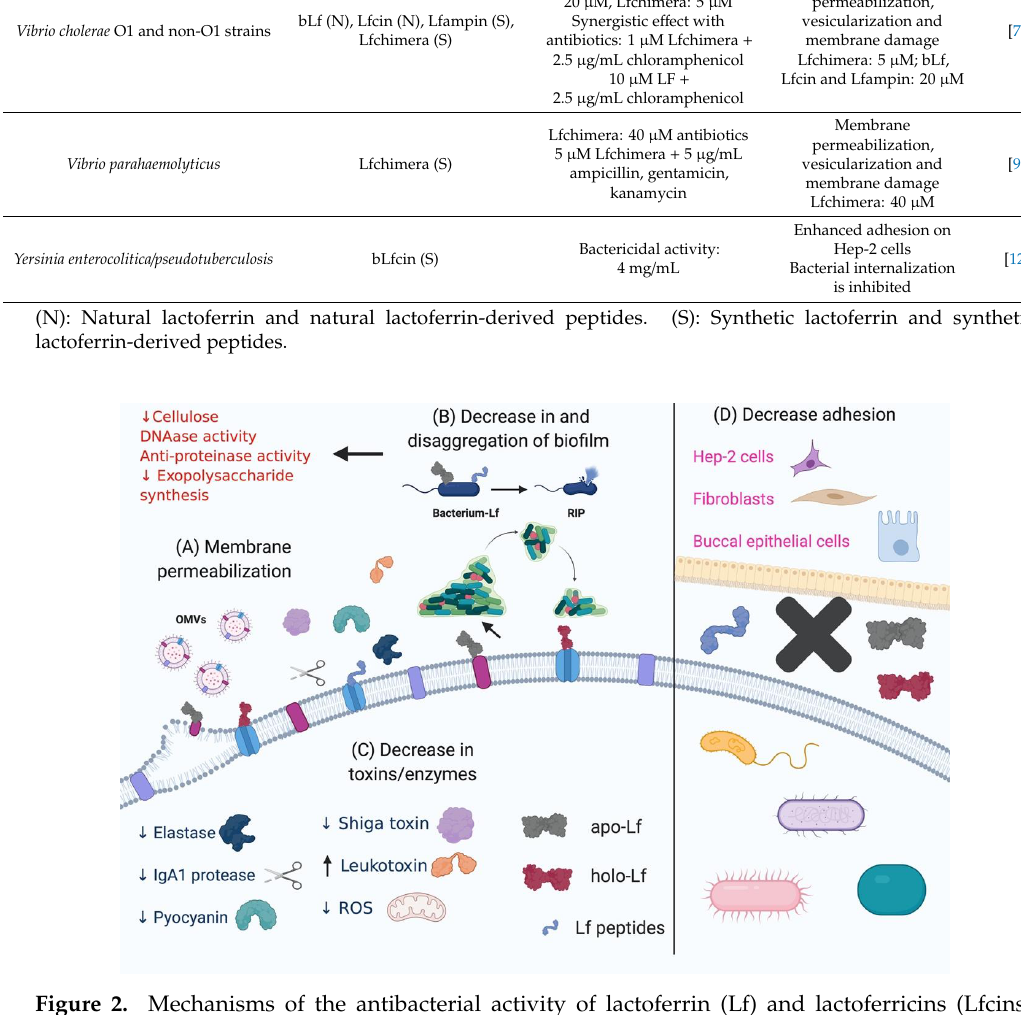
Figure 2. Mechanisms of the antibacterial activity of lactoferrin (Lf) and lactoferricins (Lfcins). ( A ) Membrane permeabilization: Lf and Lfcins bind to membrane components of bacteria, resulting in membrane permeabilization and bactericidal effects. ( B ) Decrease in and disaggregation of biofilms: Lf and Lfcins, through different mechanisms (DNAse activity, antiproteinase activity and decrease in exopolysaccharide and cellulose synthesis), diminish biofilm formation. ( C ) Decrease in toxins/enzymes: Lf and Lfcins reduce the synthesis of certain proteins (elastase, pyocyanin, Shiga toxin and